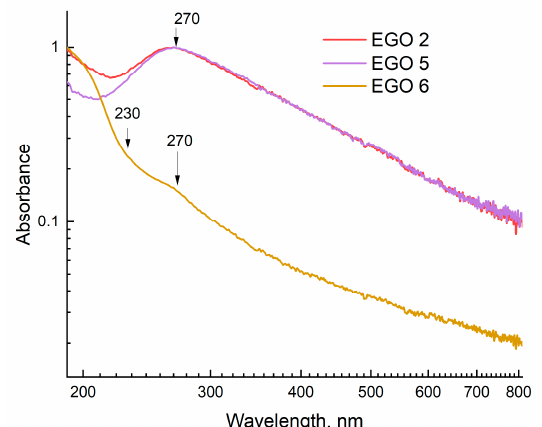
Figure 4. Absorption spectra of samples: EGO 2, two-step synthesized samples of EGO with a separated cathode–anode compartment with additional current treatment and a platinum rod as an anode (procedure 3); EGO 5, one-step synthesized samples of EGO with a separated cathode–anode compartment without further current treatment (procedure 5); and EGO 6, one-step synthesized samples of EGO with a combined cathode–anode compartment (procedure 6); path length is 1 mm.